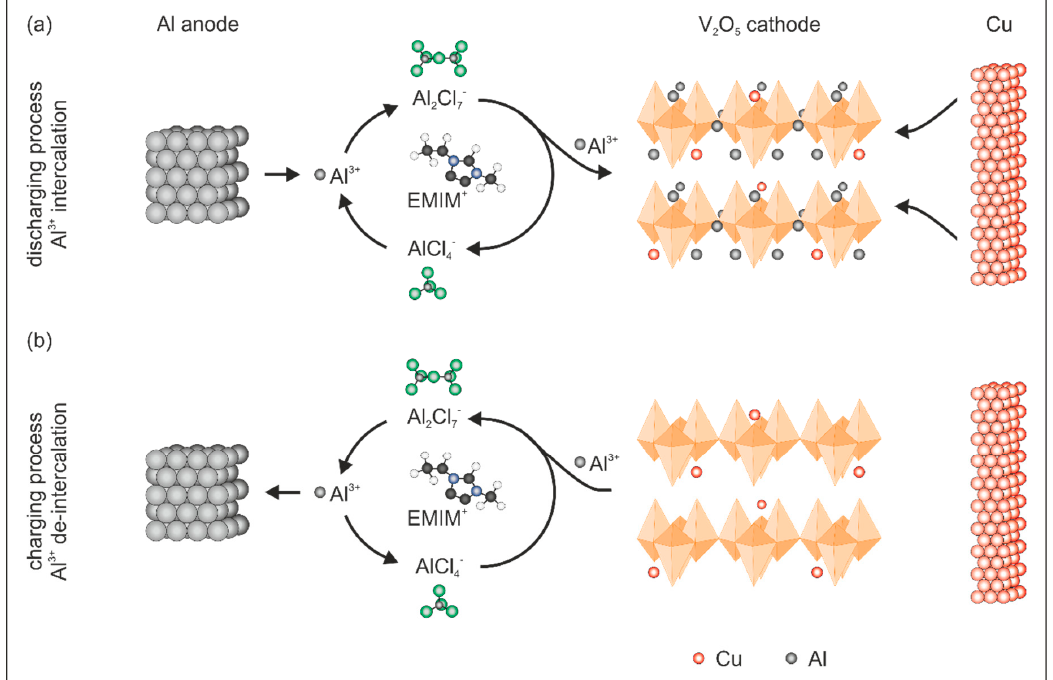
Figure 3. Simplified schematic representation of the occurring reactions during the discharge and charge process in the Cu doped V 2 O 5 cathode. ( a ) In the discharge process, Al 3+ are electrochemically stripped from the Al anode and are intercalated into the V 2 O 5 cathode via an intermediate Al 2 Cl 7 − complex. ( b ) During the charge process, Al 3+ is de ‐ intercalated from the V 2 O 5 cathode forming the intermediate Al 2 Cl 7 − complex and metallic Al is deposited on the